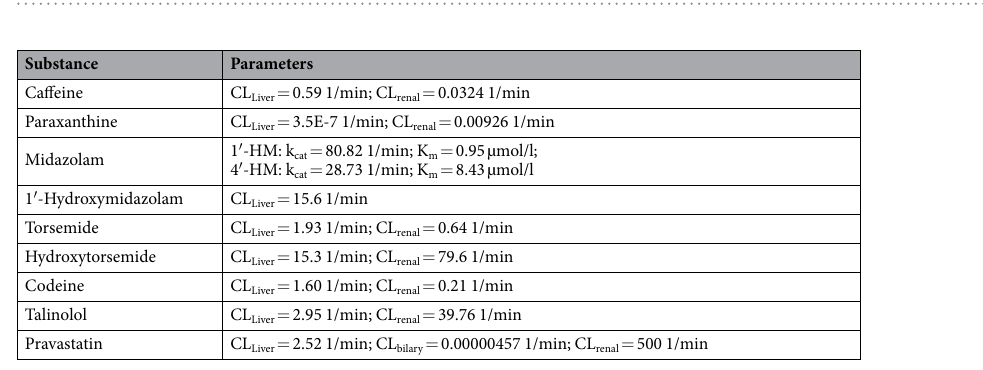
Table 3. Parameters of the active clearance